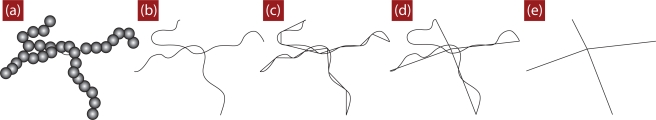
Schematic drawing summarizing the construction of the (three–dimensional) primitive paths (PP). (a) Microscopic configuration. For clarity reasons, two out of hundreds of chains are shown. (b) For the construction of the PP within the Z1 code, the backbone is considered infinitely thin, and chain ends are fixed in space. (c) The length of the multiple disconnected path is monotonically reduced, subject to chain-uncrossability, by introducing a smaller number of nodes. (d) Upon iterating the geometrical procedure one converges at a final state, the shortest path, shown in (d), together with the original chain, and alone in (e). Each chain carries a part of the multiple disconnected shortest path, called its PP. A single PP is often characterized by its conformational properties such as reflected by contour length Lpp and number of kinks, denoted as Z. Self–entanglements are not taken into account into the analysis.